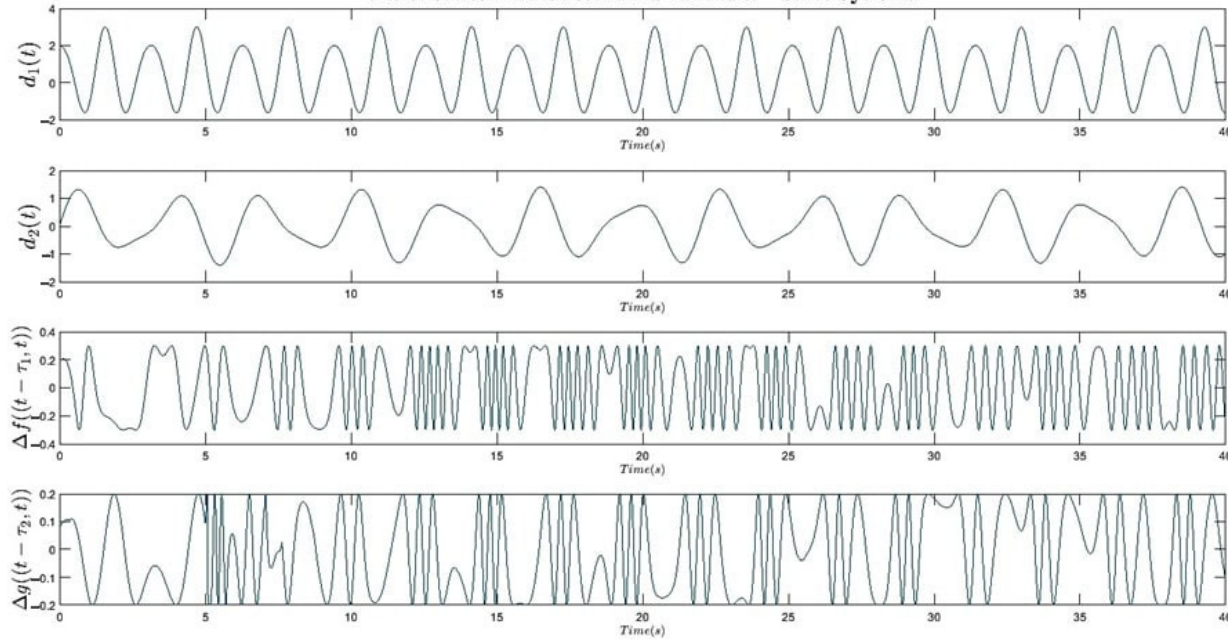
Figure 7. Uncertainty and disturbances of the master and slave systems.